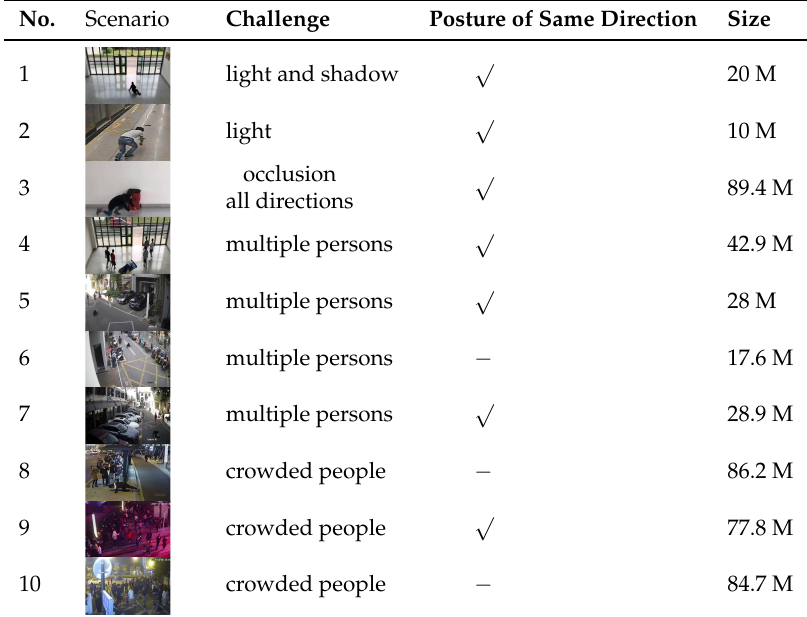
Table 1. The illustration of our video dataset Postures of Fall (PoF) No. Scenario Challenge Posture of Same Direction